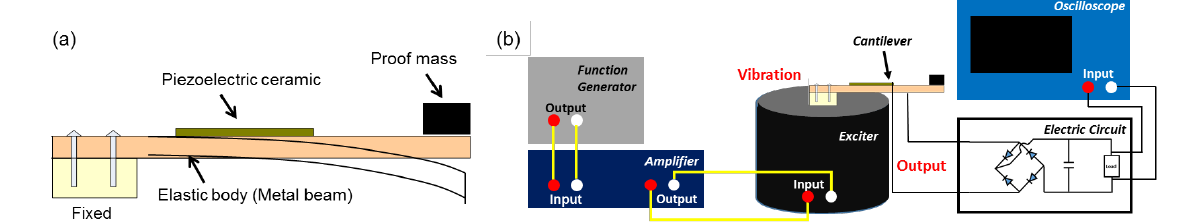
Figure 1. ( a ) Schematic of cantilever type piezoelectric energy harvester; ( b ) conventional experimental setup to evaluate cantilever type piezoelectric energy harvester.